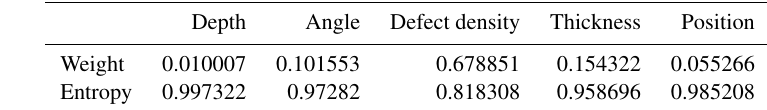
Table 2. Entropy weight of evaluation indicator.